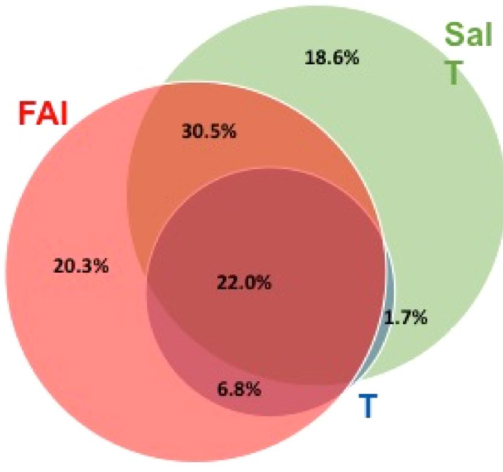
Figure 2. Venn diagram of elevated Salivary Testosterone, Serum Testosterone, and Free Androgen Index in the diagnosis of PCOS. Venn diagram of the percent of PCOS patients with a raised salivary testosterone (salT), a raised free androgen index (FAI) or a raised serum testosterone (T) showing that 100% of patients could be accounted for by a combination of the salivary testosterone and FAI, but indicating that not one single androgen measure would encompass the diagnosis of PCOS in all patients